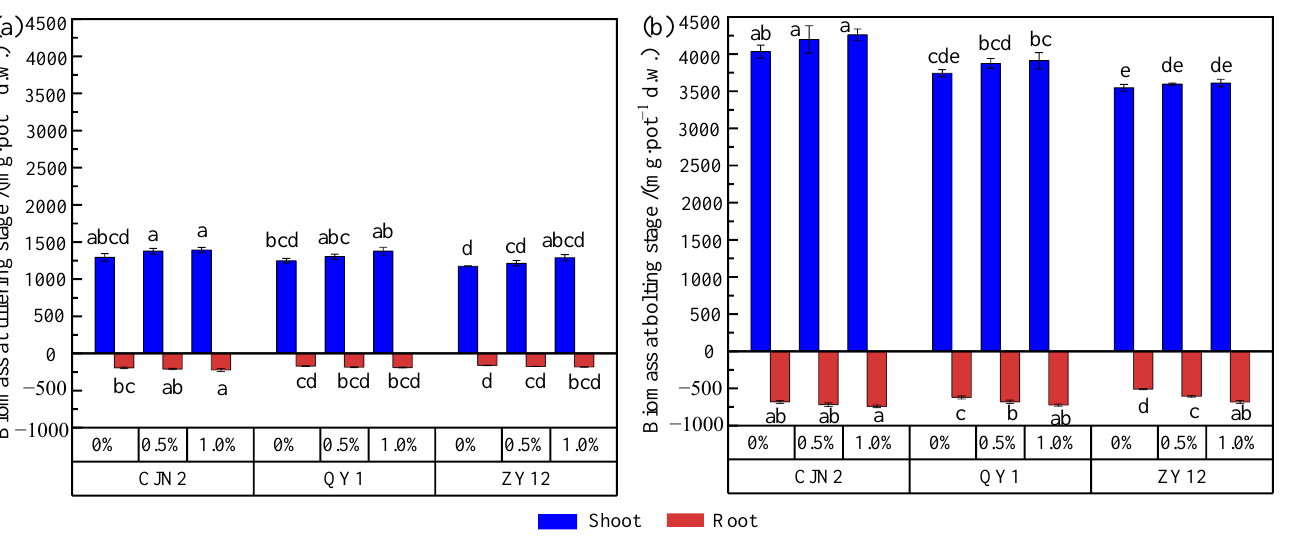
The cadmium (Cd), Fe, and Mn concentrations in the shoots, roots, and root surface (Fe plaque) were consistently higher at the bolting stage (Figure 3). However, the three rice cultivars differed in Cd-accumulation abilities. The roots and shoots of CJN2 (high ROL rate, high porosity) and ZY12 (low ROL rate, low porosity) had the lowest and highest Cd concentrations at both growth stages with an increase in RM ( p < 0.05) (Figure 3a). The cadmium (Cd) concentration in shoots of ZY12 was 1.42 times higher than that of QY1 and 2.43 times higher than that of CJN2 under 1% RM treat- ment at the bolting stage. These results further indicated that the cultivar with a high ROL rate and porosity accumulated the lowest Cd concentrations in the shoot among the three cultivars, which is consistent with previous studies [18]. The ROL rate is considered to be a critical biological factor to control F e plaque formation [31,32]. It is well known that a higher ROL rate can promote Fe plaque formation under the same Fe 2+ concentration in the growth environment [20]. The Fe plaque decreases the absorption of heavy metals by rice roots owing to adsorption or coprecipitation. This may explain the lower Cd accumulation by the rice cultivar with a high ROL rate and porosity. The cadmium (Cd) concentration in shoots and roots of the three rice cultivars decreased, whereas the Fe and Mn concentrations increased, at both growth stages, in response to RM addition (Figure 3b,c). Compared with those under the 0% RM treatment, the Cd concentrations in the shoots of ZY12, QY1, and CJN2 under the 1% RM treatment decreased by 42.37%, 35.14%, and 50.00% at the tillering